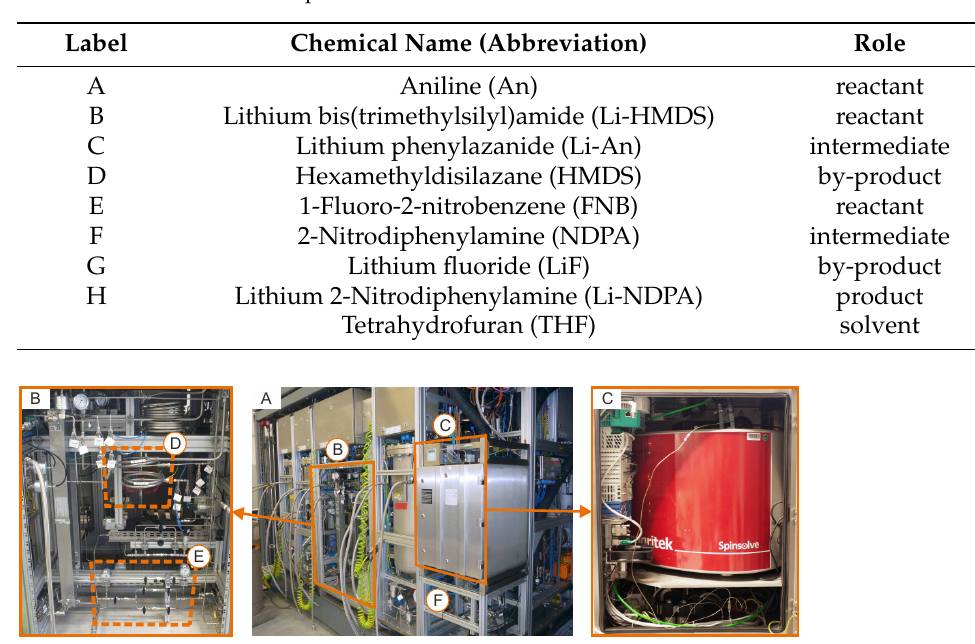
Table 3. List of chemical components involved in lithiation reaction.